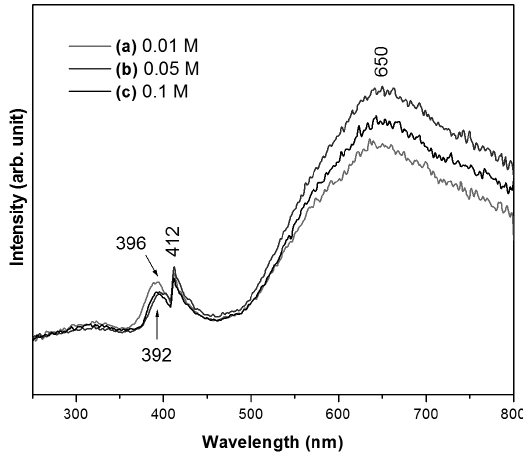
Figure 4. PL spectra of samples: (a) F2, (b) F3 and (c) F4.